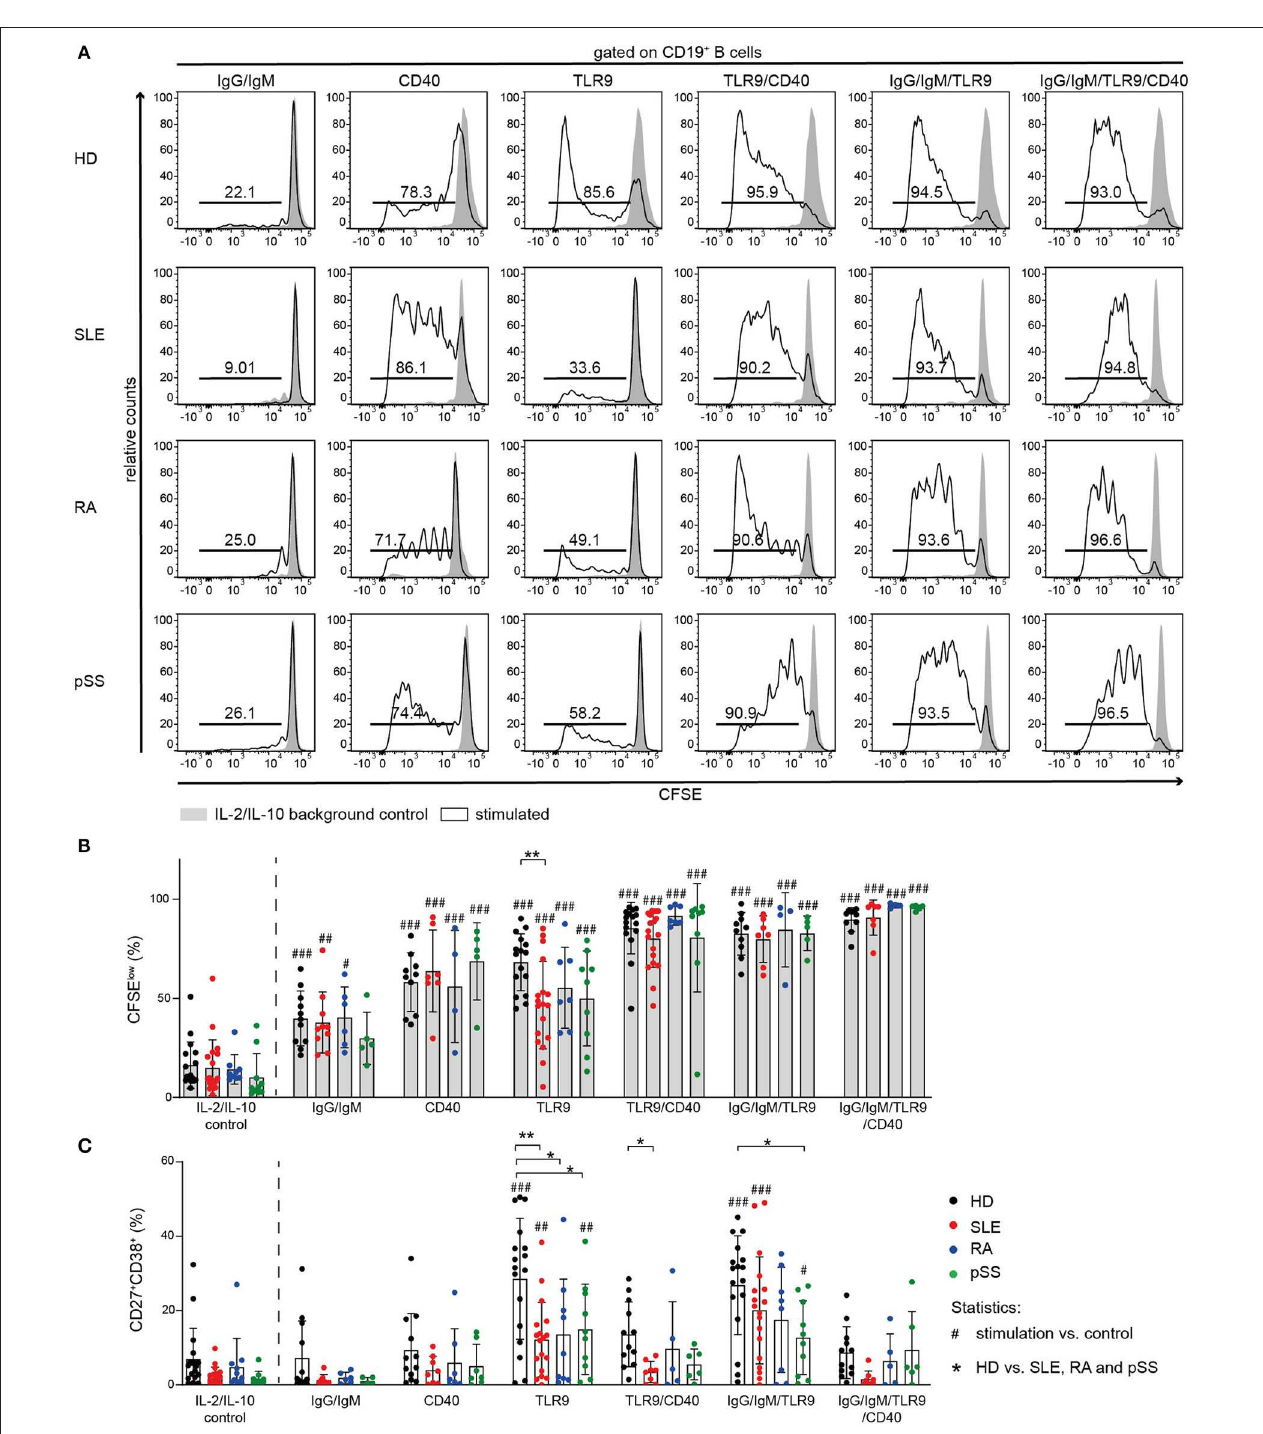
FIGURE 5 | Proliferation of AID B cells upon CD40 stimulation or combined stimulation of BCR and TLR9 is comparable to HD. B cells from HD (black), SLE (red), RA (blue), and pSS (green) patients were stimulated with anti-IgG/IgM, CD40L, or CpG and the combinations CD40L/CpG, CpG/anti-IgG/IgM, or CD40L/CpG/anti-IgG/IgM. (A) Representative CFSE histograms of HD, SLE, RA, and pSS B cells after 5 days of culture for the indicated stimulus (lines) compared to background control (gray). (B) Percentages of CFSE low B cells [n(HD/SLE/RA/pSS) = 17/19/9/10 (IL-2/IL-10 control); 11/10/6/5 (IgG/IgM); 10/7/4/5 (CD40); 16/18/7/9 (TLR9); 10/7/4/5 (TLR9/CD40); 16/19/7/9 (IgG/IgM/TLR9); 10/7/4/5 (IgG/IgM/TLR9/CD40)]. (C) Resulting frequency of CD27 + CD38 + B cells upon activation in culture [n(HD/SLE/RA/pSS) = 18/18/11/10 (IL-2/IL-10 control); 12/8/6/5 (IgG/IgM); 12/8/7/7 (CD40); 17/18/9/10 (TLR9); 12/8/5/6 (TLR9/CD40); 17/18/8/10 (IgG/IgM/TLR9); 12/8/5/6 (IgG/IgM/TLR9/CD40)]. Bars shown represent mean ± SD (ANOVA with DMCT, * p ≤ 0.05, ** p ≤ 0.01; # p ≤ 0.05, ## p ≤ 0.01, ### p ≤ 0.001).